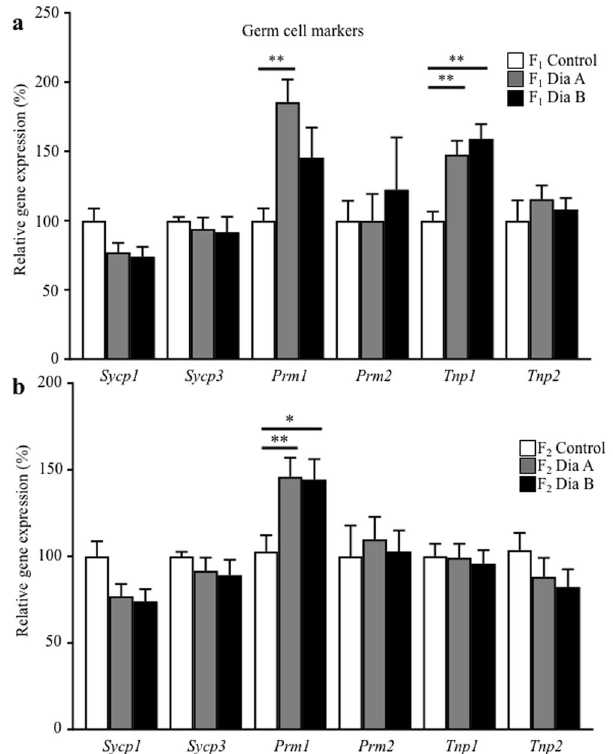
Figure 8. Transgenerational effects of diabetes on testicular gene expression of the F 1 and F 2 male generations. ( a ) qPCR analysis of the expression of genes encoding proteins associated with spermatogenesis (synaptonemal complex protein 1 ( Sycp1 ), synaptonemal complex protein 3 ( Sycp3 )), and spermiogenesis (protamine 1 ( Prm1 ), protamine 2 ( Prm1 ), transition protein 1 ( Tnp1 ) and transition protein 2 ( Tnp2 )) in the F 1 testes (F 1 Control, n = 8; F 1 Dia A n = 10; F 1 Dia B n = 5). ( b ) Expression changes in the testes of the F 2 males (F 2 Control n = 6; F 2 Dia A n = 12; F 2 Dia B n = 11). The graph illustrates the relative expression of the selected genes. The control group represents 100% of relative gene expression. The values are means ± SEM. * P < 0.05, ** P < 0.01 vs . Control group by Dunnett’s post hoc